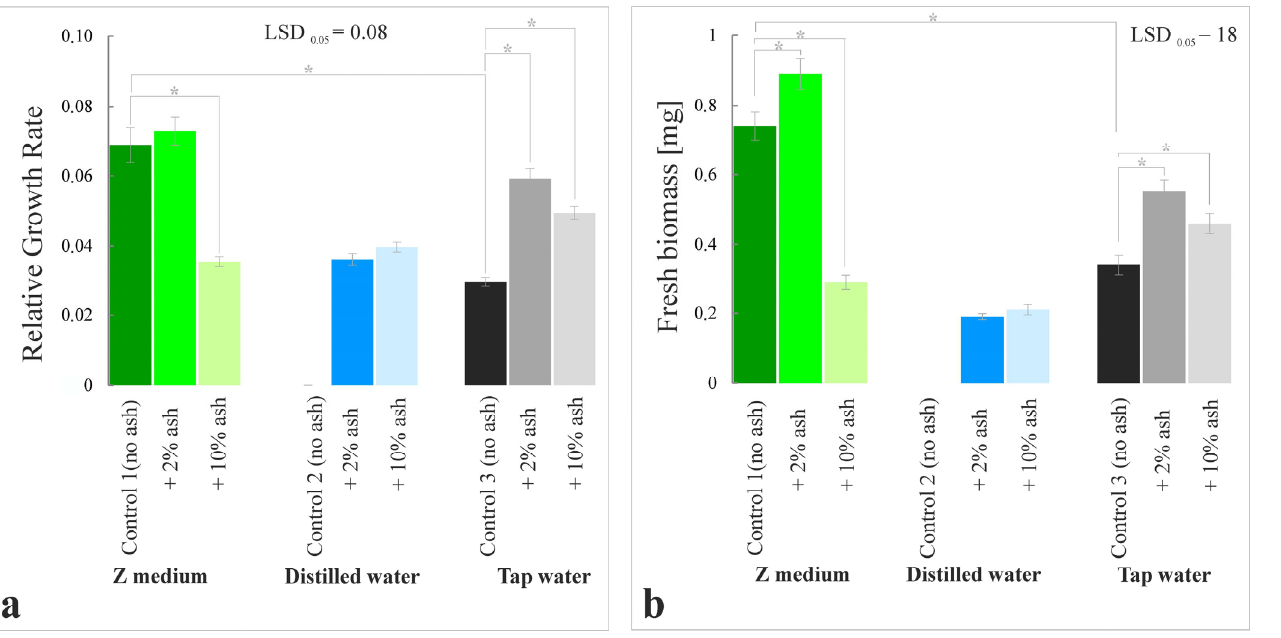
Figure 2. Relative growth rate (RGR) ( a ) and fresh biomass ( b ) in S. polyrrhiza plants grown on different variants of sorghum ash-supplemented media. Bars denote means ± SE; asterisks show statistically significant differences between particular series; LSD at alpha level of 0.05.